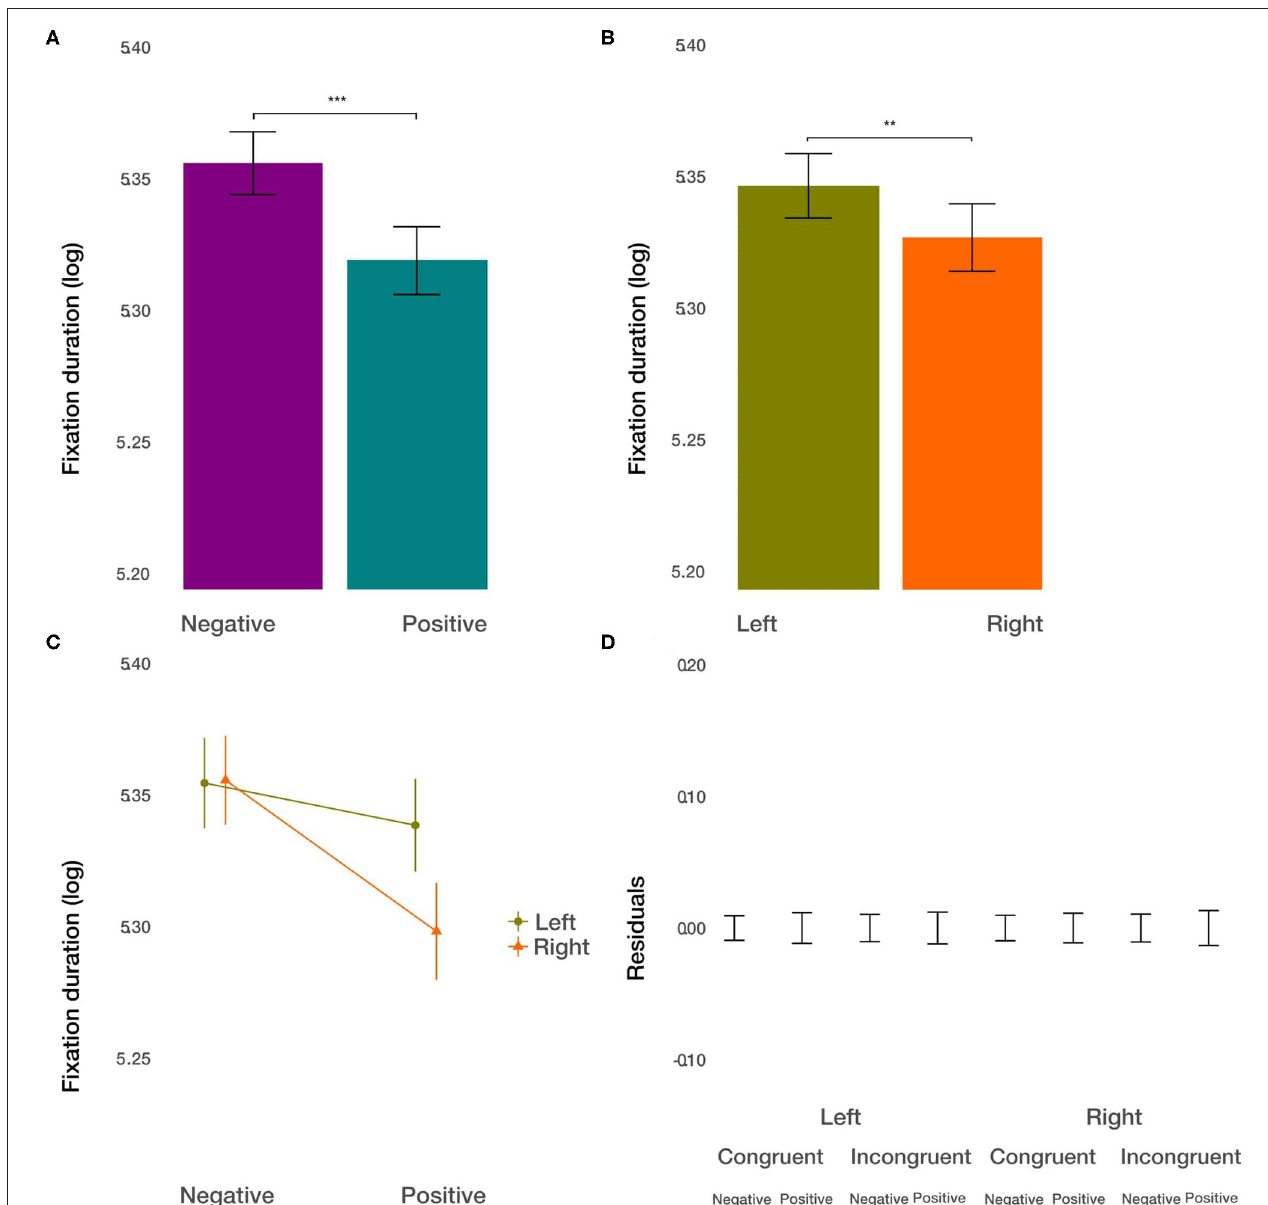
FIGURE 4 | Fixation duration results. (A) The main effect of image valence (negative vs. positive). (B) The main effect of the side (left vs. right). (C) The interaction between valence and side. (D) Averaged residuals of all condition combinations from the fixation duration linear mixed model. In all plots, bars represent mean values and whiskers standard error of the mean. Stars represent significance levels: ** p < 0.01 and *** p < 0.001.